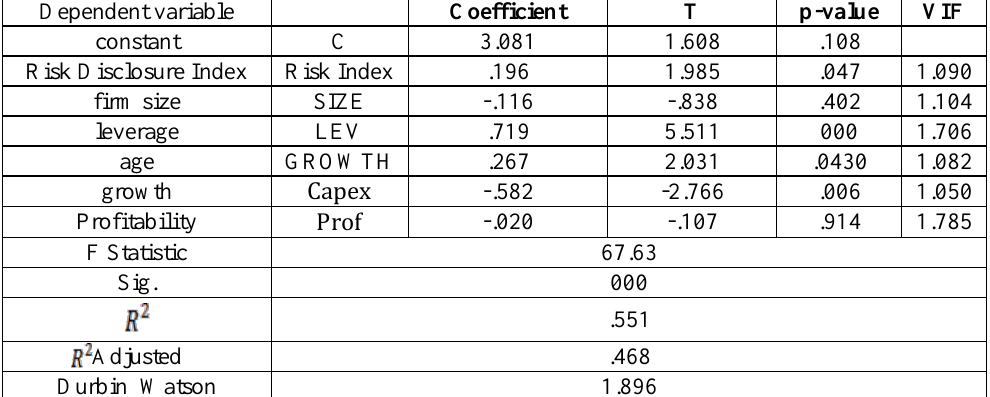
Table 4. Regressions of firm value on risk disclosure (empirical